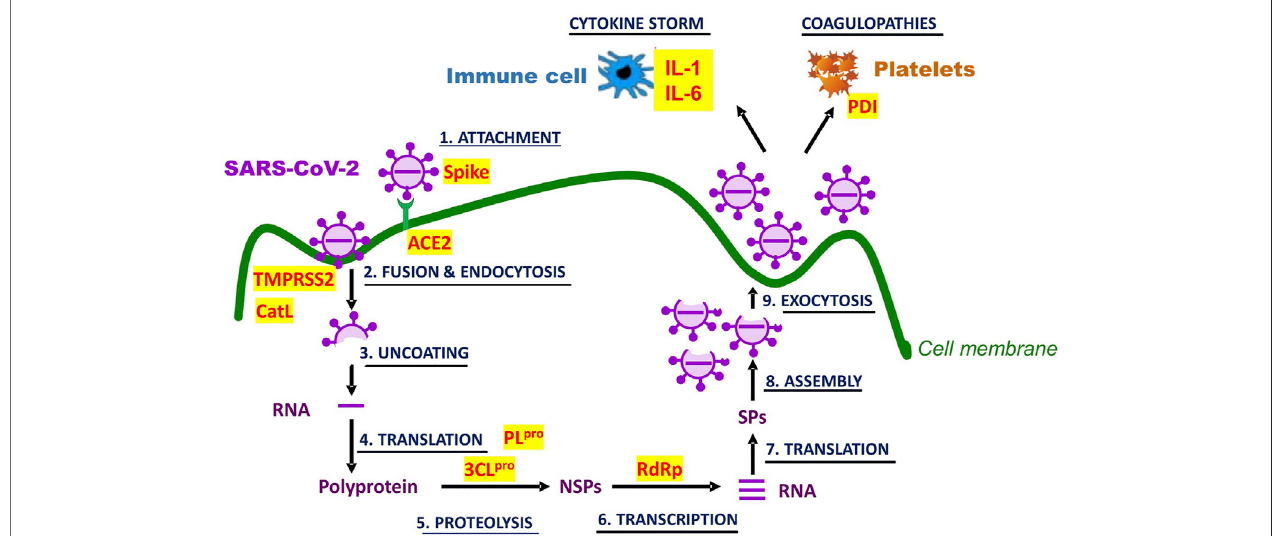
FIGURE 3 | Molecular and physiological targets of quercetin and isoquercetin in Covid-19. SARS-CoV-2 infection and life cycle are graphically represented. Potentialtargetsforinhibitionbythe fl avonolsarewritteninredandhighlightedinyellow.TheirfullidentityandtheroleinCovid-19pathogenesisaredescribedinthetext. NSPs stand for non-structural proteins, and SPs for structural